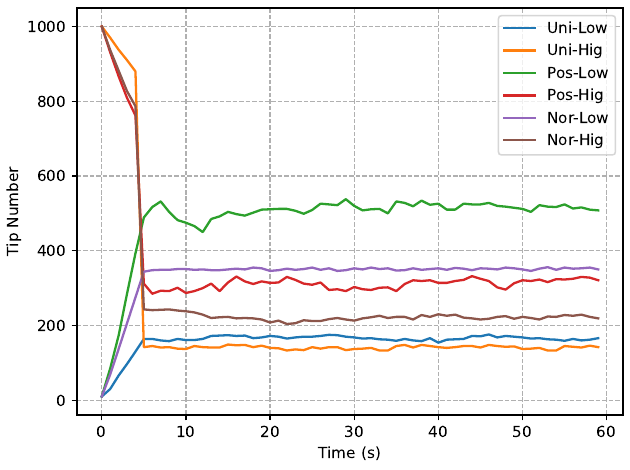
Figure 5. The Ledger